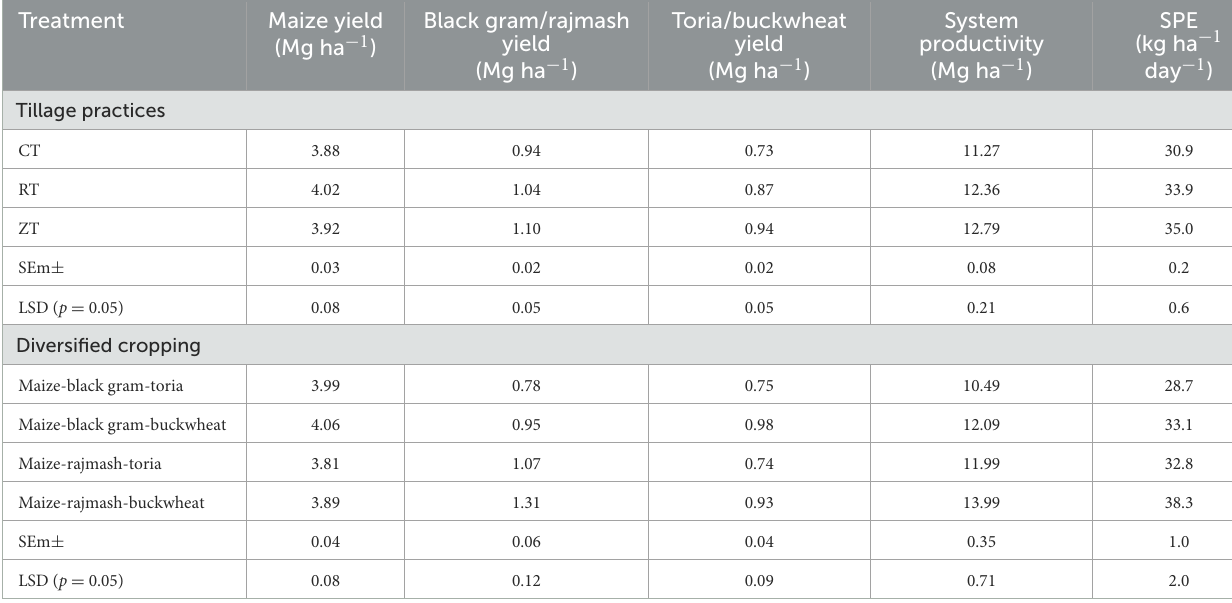
TABLE 1 Impact of different tillage practices and diversified cropping on crop productivity (mean of 3 years). Treatment